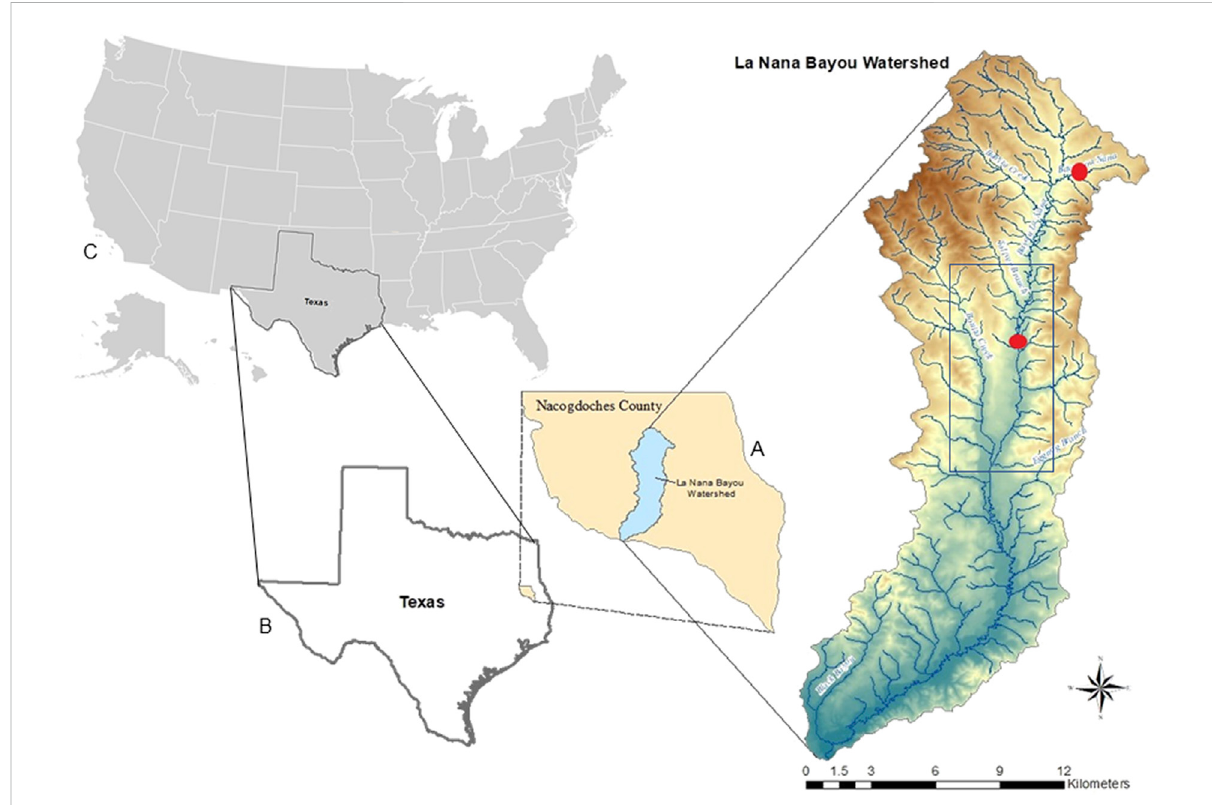
FIGURE 1 Location of La Nana Creek watershed in Nacogdoches County (A) in east Texas, State of Texas (B) , United States (C) . Red circles represent the two surveyed sites within the watershed (upstream and downstream). Color pattern in the watershed represents upper sub-watershed (brown) and lower sub-watershed (blue). Open rectangle on La Nana watershed depicts the actual location of the city of Nacogdoches within the